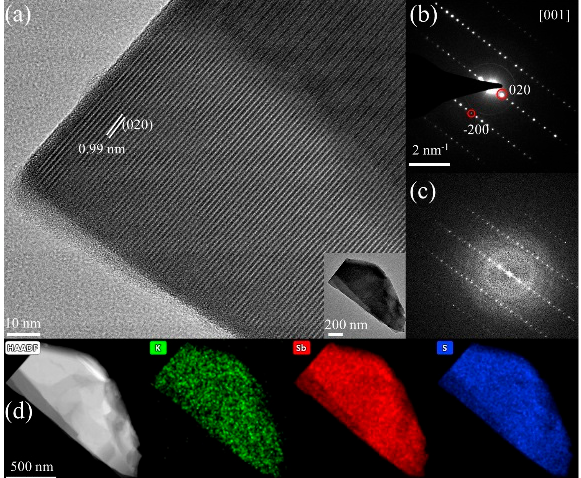
Figure 3. ( a ) TEM image of KSb 5 S 8 . ( b , c ) Experimental selected area electron diffraction (SAED) and fast Fourier transformation (FFT) patterns along the [001] zone axis. ( d ) Energy dispersion spectrometry (EDS) elemental mappings of KSb 5 S 8 .